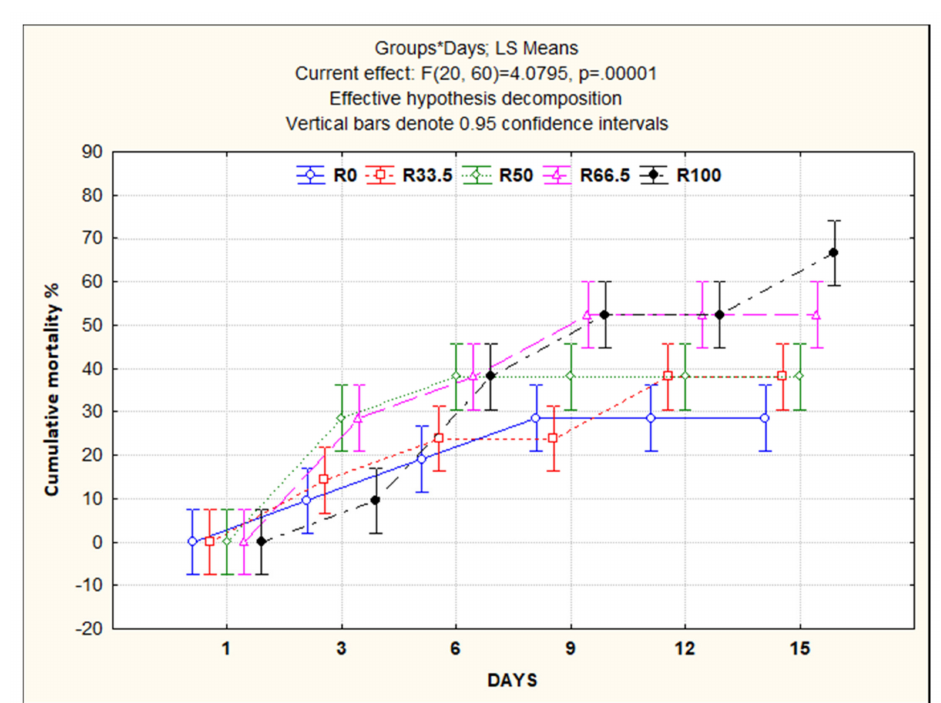
Figure 6. Cumulative mortality rate of Clarias gariepinus fed experimental diets in which fishmeal was replaced by plant protein (soybean and sunflower meal) after 30 days and challenged with pathogenic Aeromonas sobria for 14 days. R0, R33.5, R50, R66.5 and R100: see legend of Figure